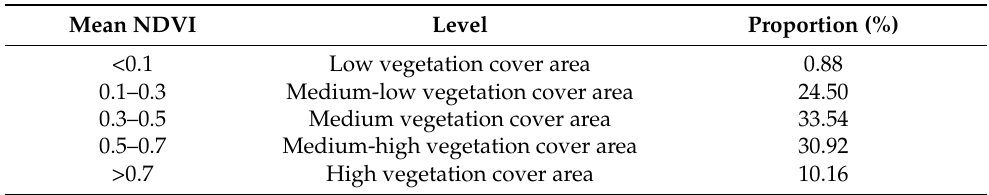
Table 3. Vegetation coverage levels in the upper and middle reaches of the YRB during the growing season from